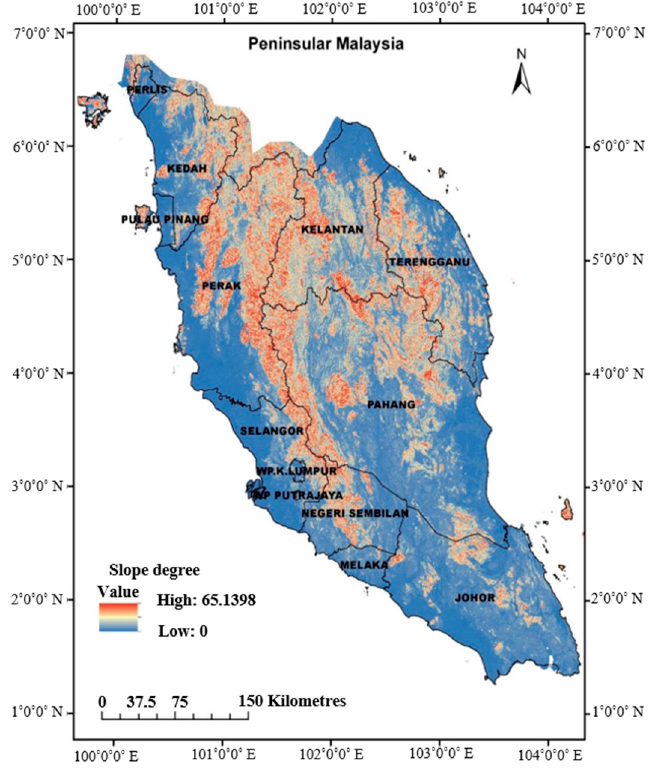
Figure 8. The slope degree for Peninsular Malaysia.